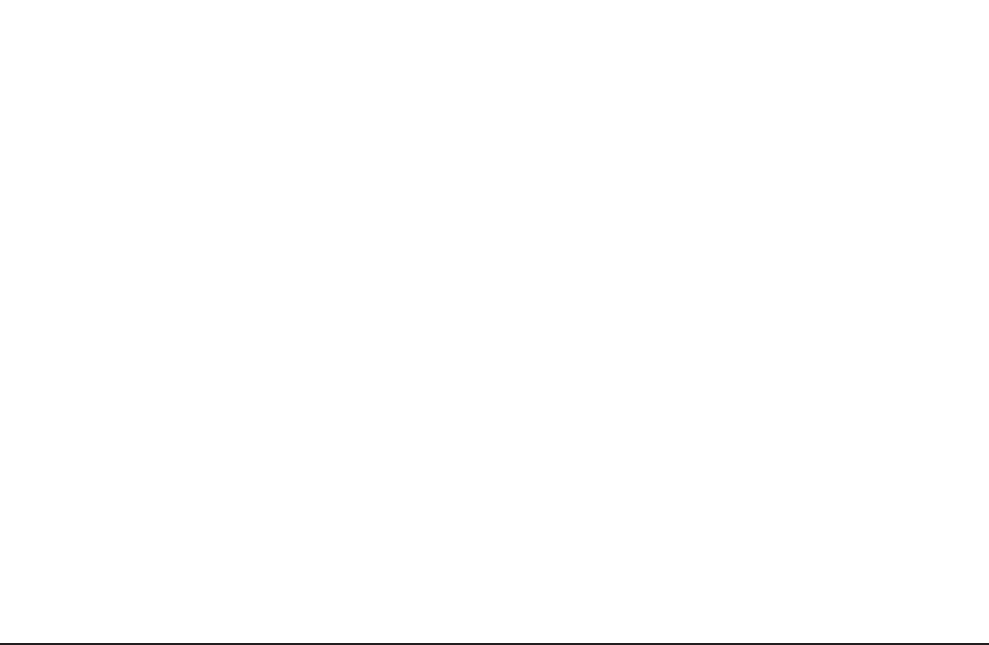
FIGURE A1 | The effects of changes to the amino acids flanking phosphorylation site 1 of A. thaliana PDH E1 α . (A,B) indicate double and multiple changes, respectively. Bold underlined letters in the amino acid sequence indicates the